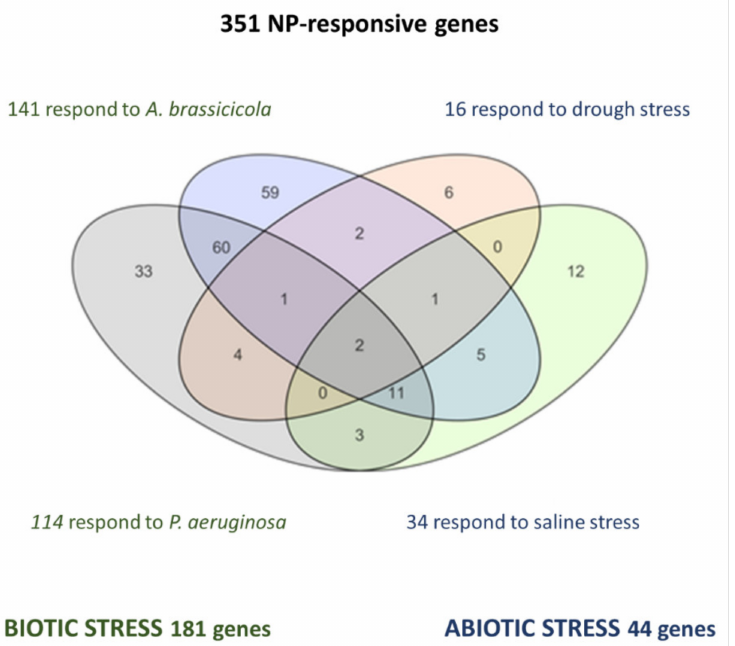
Figure 5. Subsets of biotic or abiotic stress-responsive genes in the set of 351 DE genes [34]. Clustering analysis shows that key genes involved in recognizing pathogens and the transduction of signals to activate SAR are repressed under treatment with NPs (Figure